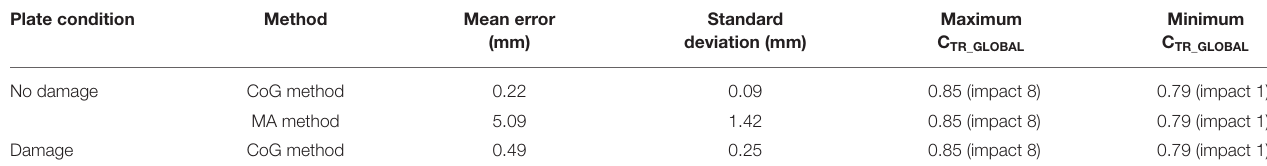
TABLE 3 | Post-processing results for the original grid.